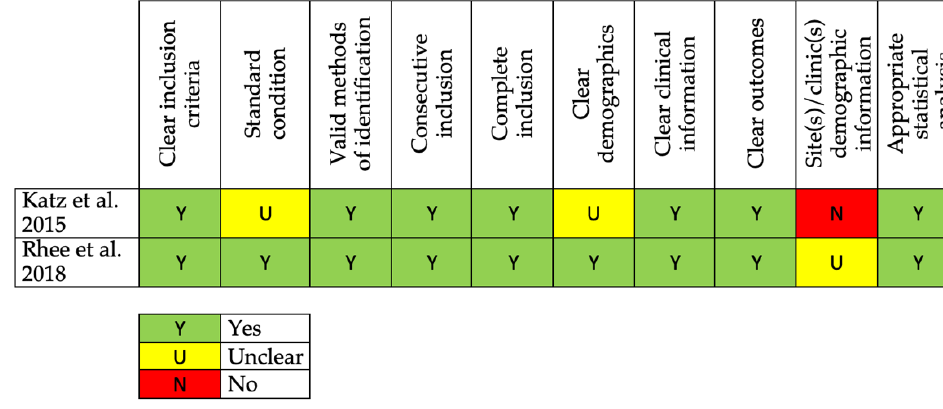
Figure 4. The Joanna Briggs Institute critical appraisal tool for CS studies [25,39].